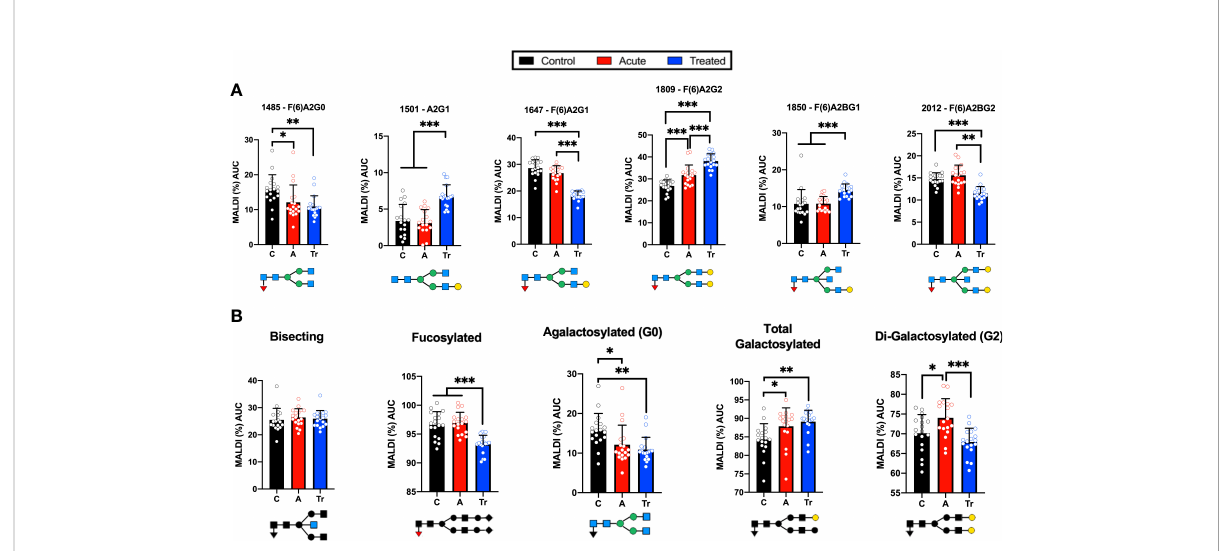
FIGURE 3 Con fi rmatory set of LD patient serum assayed using the high-throughput MALDI method (A) IgG N-glycans detected by MALDI analysis of Ab- captured IgG from n=18 cohorts individually run in triplicate +/- S.D. and reported as the percent of the total identi fi ed N-glycan m/z peak intensity. N-glycan structures displayed below (B) MALDI analysis of desialylated IgG N-glycans grouped by class from n=18 samples per cohort averaged in triplicate +/- S.D. Labeled N-glycan class structures: Bisecting, Fucosylated, Agalactosylated, Galactosylated, and